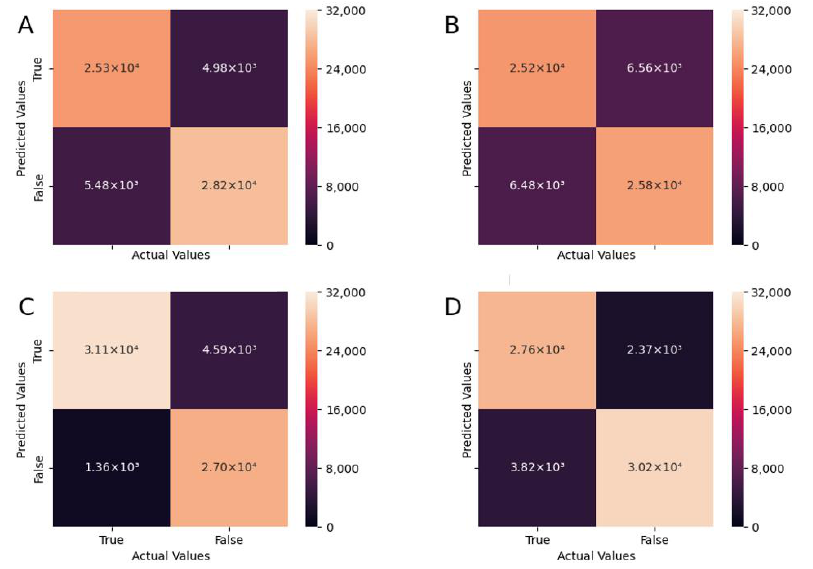
Figure 5. Confusion matrices for each model for sitting and sleep history classification. ( A ) DixonNet sitting history; ( B ) DixonNet sleep history; ( C ) ResNet-18 sitting history; ( D ) ResNet-18 sleep his- tory.